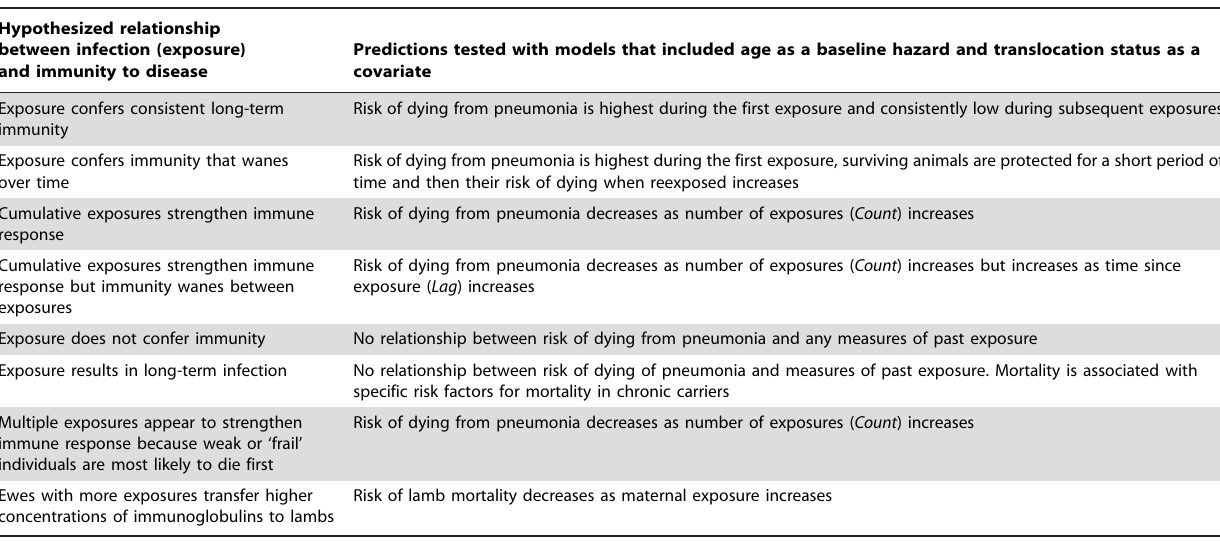
Table 1. Potential relationships between past exposure of bighorn sheep to pneumonia and mortality during subsequent pneumonia